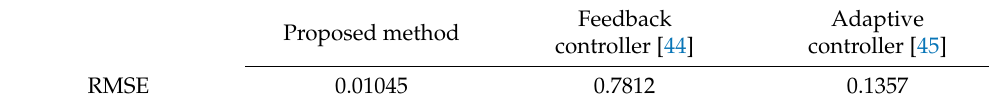
Table 1. Comparison of RMSE with different